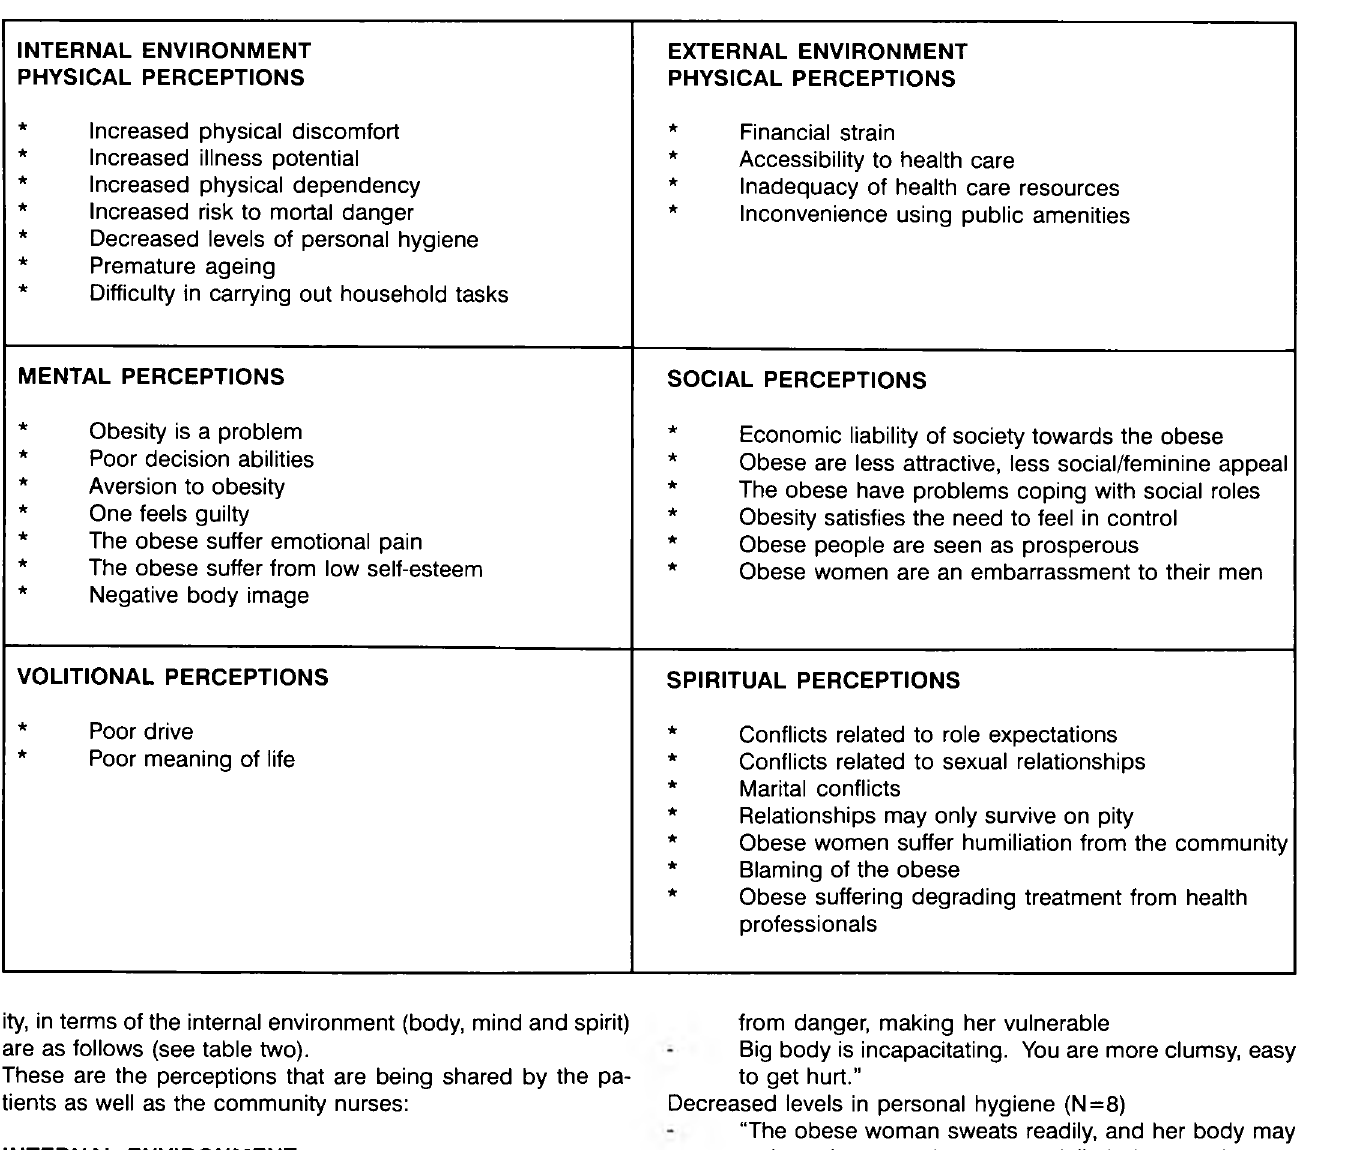
Table 2: Patient’s and Community Nurses’ Perceptions of Obesity INTERNAL